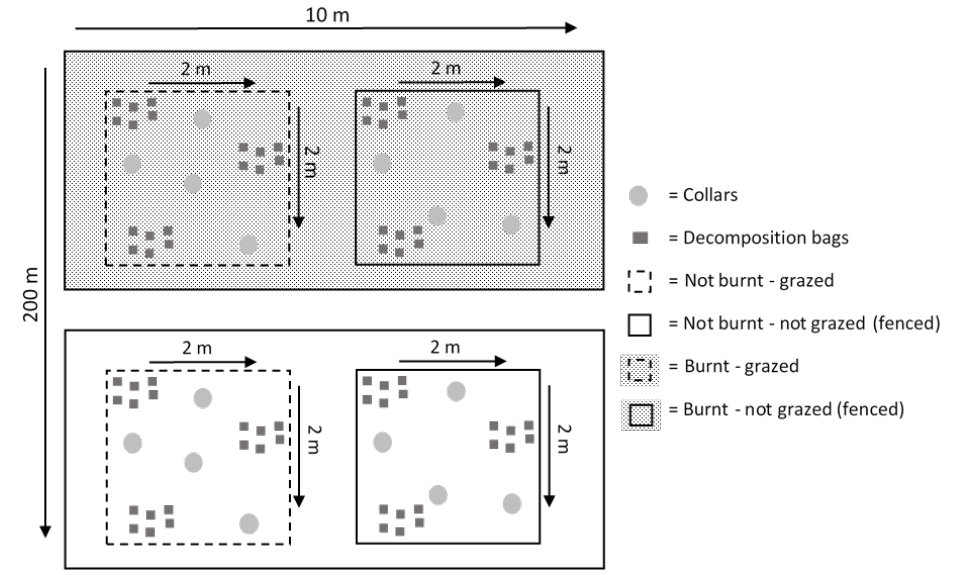
Figure 2. Schematic diagram illustrating the set-up of the plots. This experimental design was established at both Acjanaco and Wayqecha. Soils from three pits in each plot were collected for analysis. Table 1. Soil description for each land management at Wayqecha and Acjanaco (mineral soil particle size taken from Diem et al., 2017).